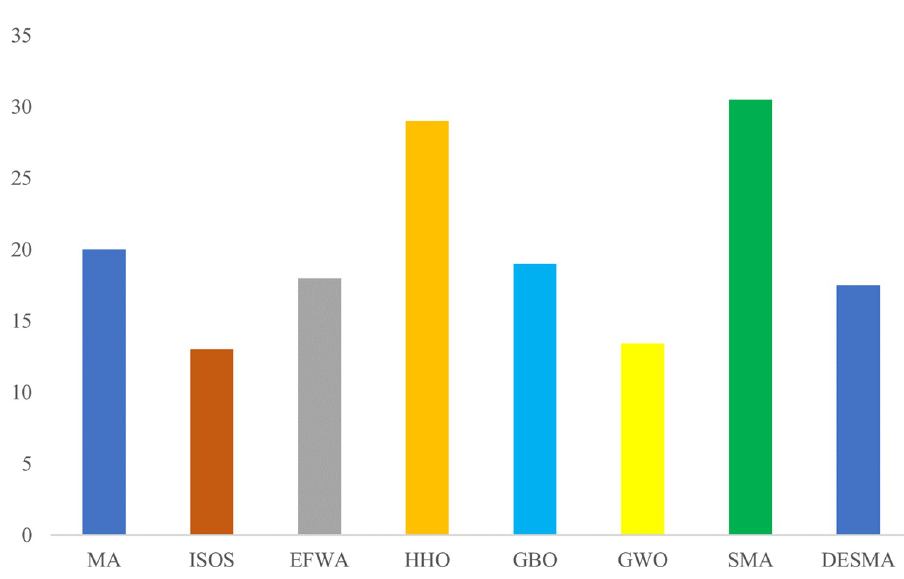
Fig 3. Comparison statistics of algorithm running time under different